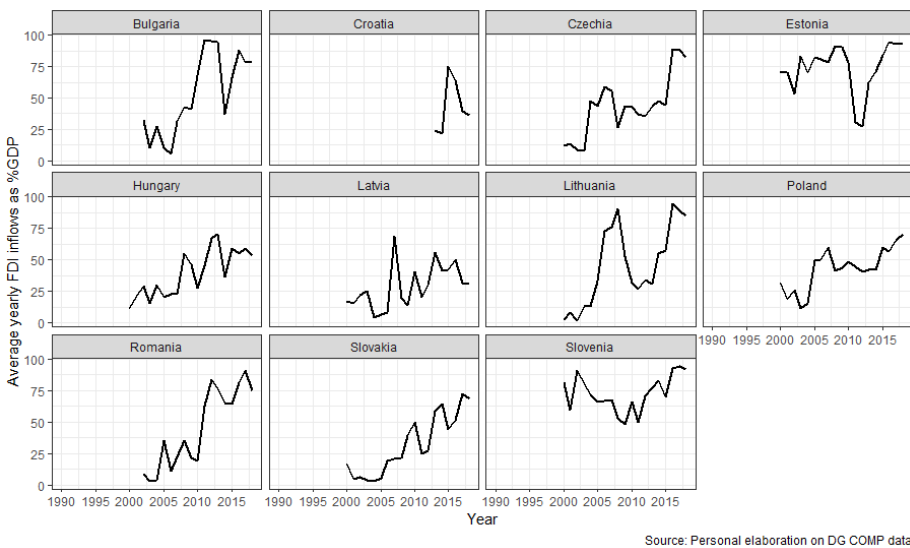
Figure A4 : Sectoral aid as % total aid in the CEECs by country